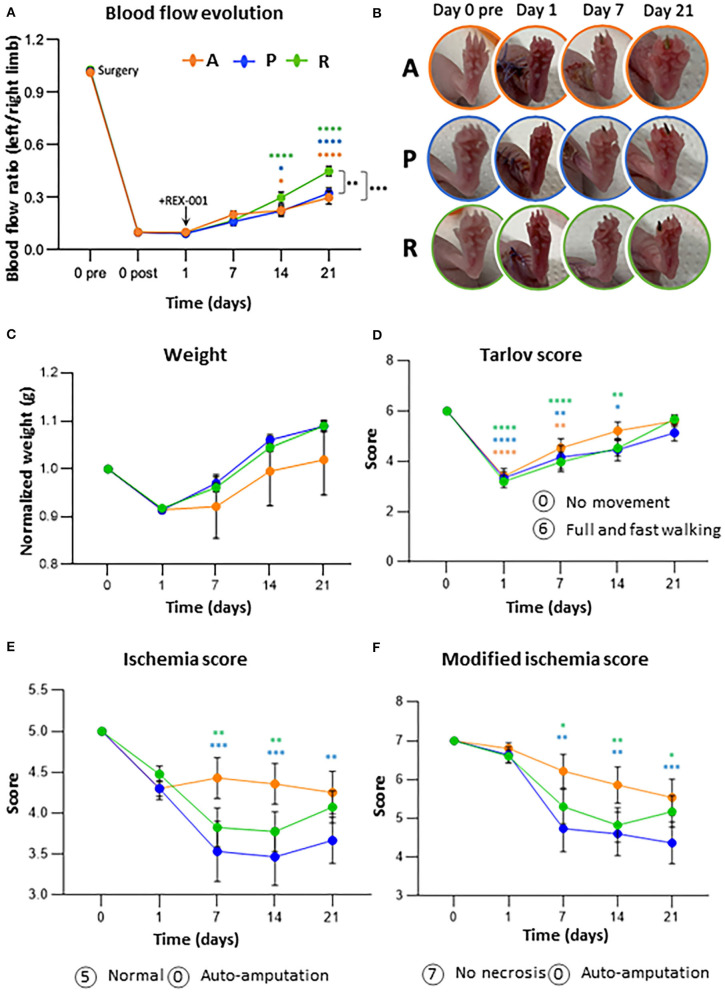
REX-001 cells enhance revascularization and blood recovery in CLTI mice. (A) Blood flow evolution per group within time. Perfusion (PU) averaged ratios of left (injured) vs. right (non-injured) limbs are shown. (B) Representative images of ischemic symptoms (inflammation, necrotic fingers) in adjuvant (A), placebos (P) and REX-001 (R) treated mice. (C) Weight changes, normalized vs. averaged values on day 0, pre-surgery. (D) Motility changes within time, according to Tarlov score values. Ischemic changes (ulceration, necrosis) detected along the assay, measured with both, the Ischemia (E) and modified ischemia scores (F). Groups tested: Balb-c nude mice injected with Adjuvant (vehicle-only) (n:14), Placebo (P, n:15) and REX-001 (R, n:20, from different donors, R1, n:6, R2, n:5, R3, n:9). The averaged values from the three assays is shown as mean ± SE. Complete scores meaning are described in Supplementary Tables 1–3. Significant differences were calculated by two-way ANOVA and Tukey post-hoc, represented as: * with colors compared to post-surgical ratios at day 0 and * in black between groups in the same day (*p-value < 0.05, **p-value < 0.01, ***p-value < 0.001, and ****p-value < 0.0001).